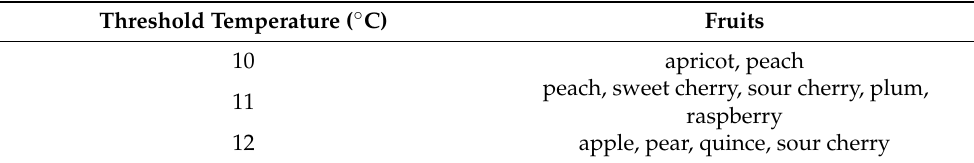
Table 1. Threshold temperature ( ◦ C) of the frost-sensitive period for fruit trees commonly grown in Serbia. Threshold Temperature ( ◦ C)